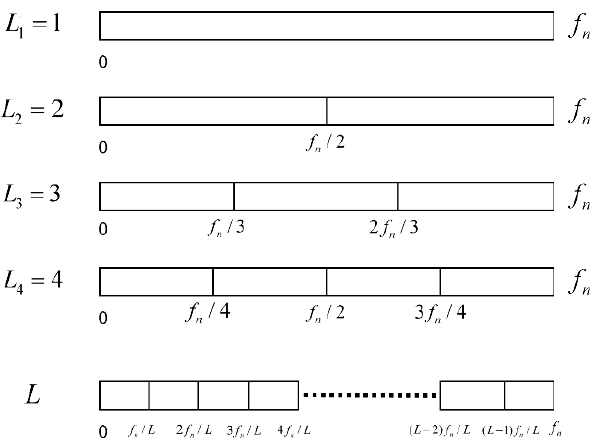
Figure 4. Hierarchical Structure of Fast Spectral Kurtosis under 1/3-bindary Tree Filter.